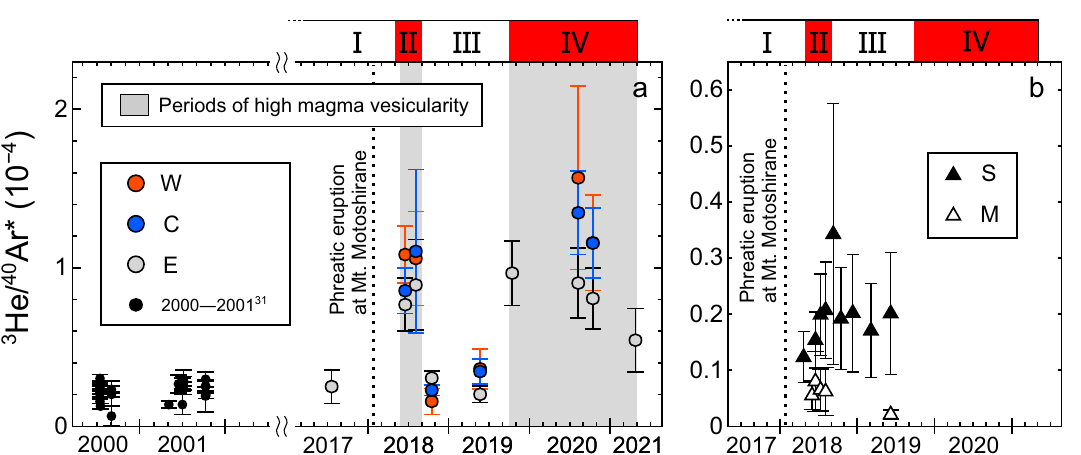
Figure 5. Temporal variations in the 3 He/ 40 Ar* ratios of fumarolic gases. ( a ) 3 He/ 40 Ar* ratios measured at the W, C, and E fumaroles in the Kitagawa geothermal area and those of fumarolic gases collected in the same area in 2000–2001 31 . Gray areas highlight the periods of high magma vesicularity, which are suggested by increased 3 He/ 40 Ar* ratios. ( b ) 3 He/ 40 Ar* ratios measured at the Sesshogawara (S) and Manza (M) fumaroles. The Roman numerals above the panels are periods defined by the average ( 3 He/ 4 He) corr ratios of the Kitagawa fumarolic gases (see text for details). Samples with uncertainties of more than 70% in the 3 He/ 40 Ar* ratios are not shown. Dotted lines indicate 23 January 2018, when a phreatic eruption occurred at Mt.